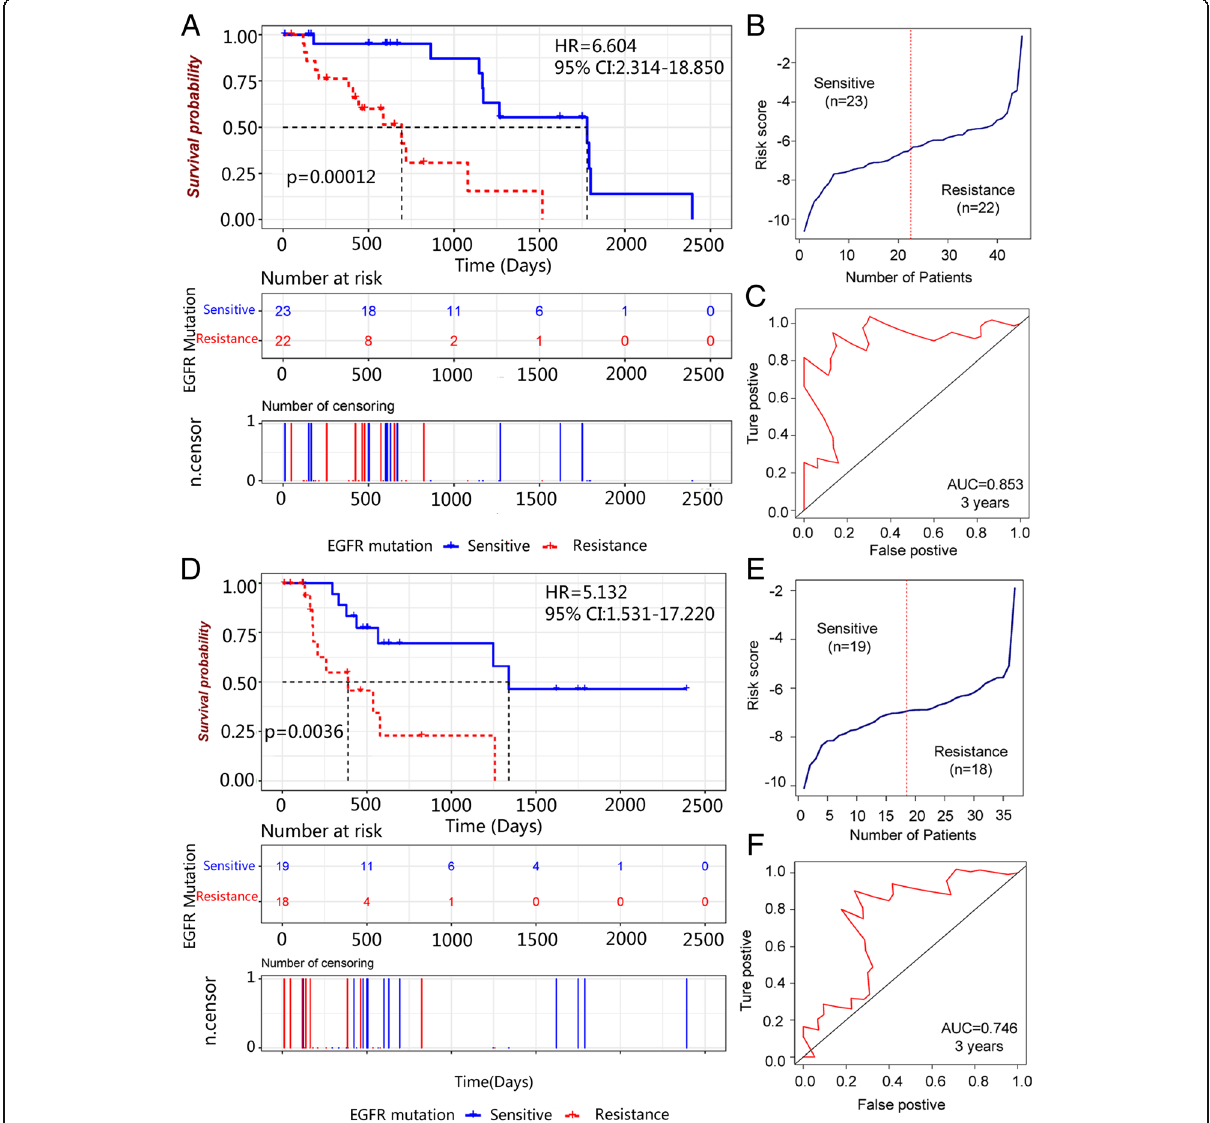
Fig. 5 Core genes prognostic validation in LUAD with EGFR-mutation cohort. a Kaplan-Meier survival curve of sensitive and resistance groups for overall survival. b RS distribution in all mutation patients. c AUC of ROC for predicting RS of OS (AUC = 0.853). d Kaplan-Meier survival curve of sensitive and resistance groups for disease free survival. e RS distribution in all mutation patients with disease free survival information. f AUC of ROC for predicting RS of DFS (AUC =